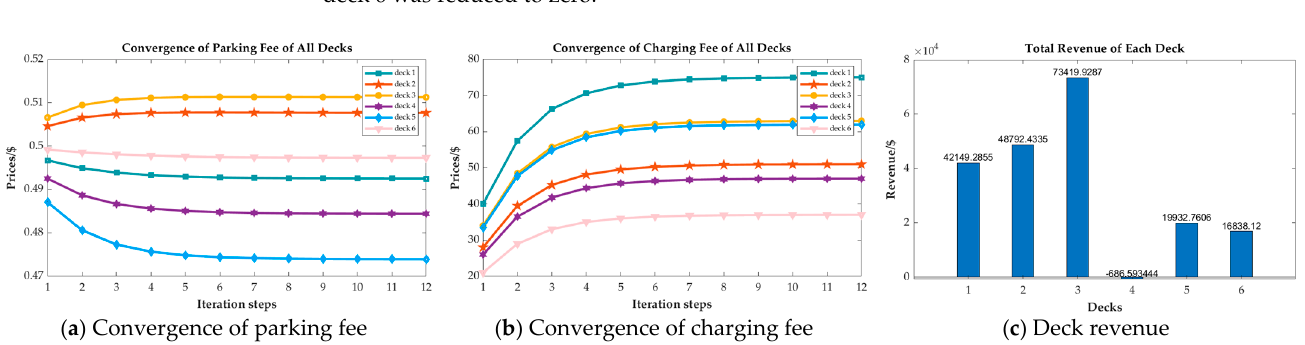
Figure 6. The charging price, parking fee, and total revenue after the number of LC customers in deck 6 was reduced to zero.